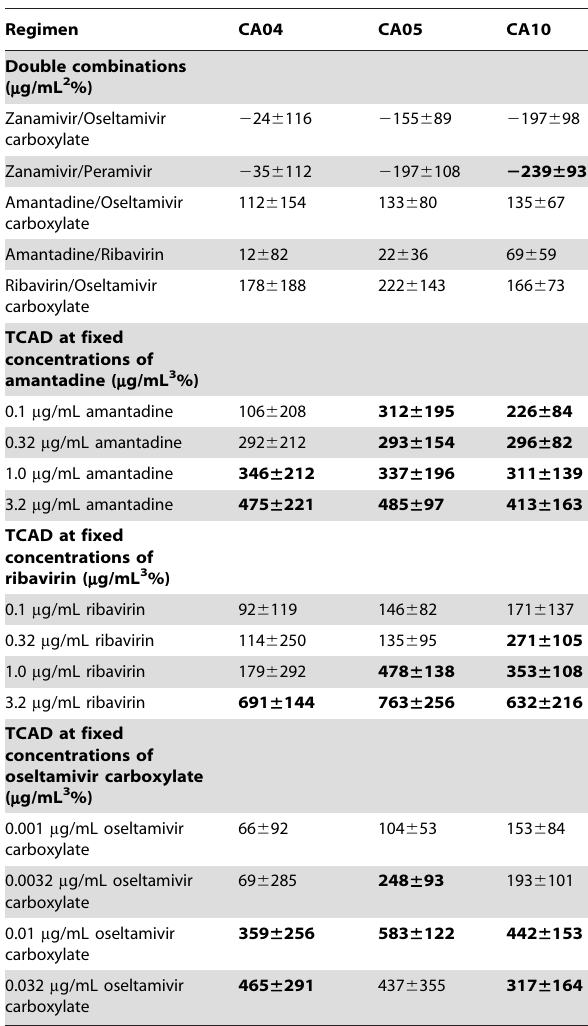
Table 1. Synergy volume of double and triple combinations of antivirals against 2009 H1N1 viruses A/California/04/09 (CA04), A/California/05/09 (CA05), and A/California/10/09 (CA10) as determined by Neutral Red